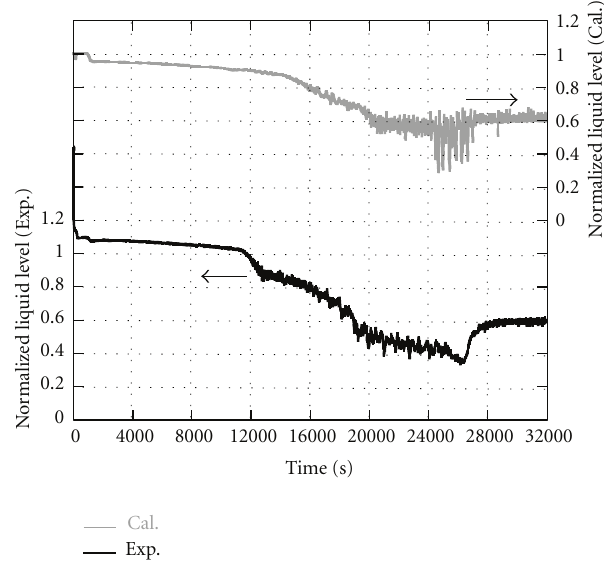
Figure 20: LSTF and RELAP5 results for core collapsed liquid level.